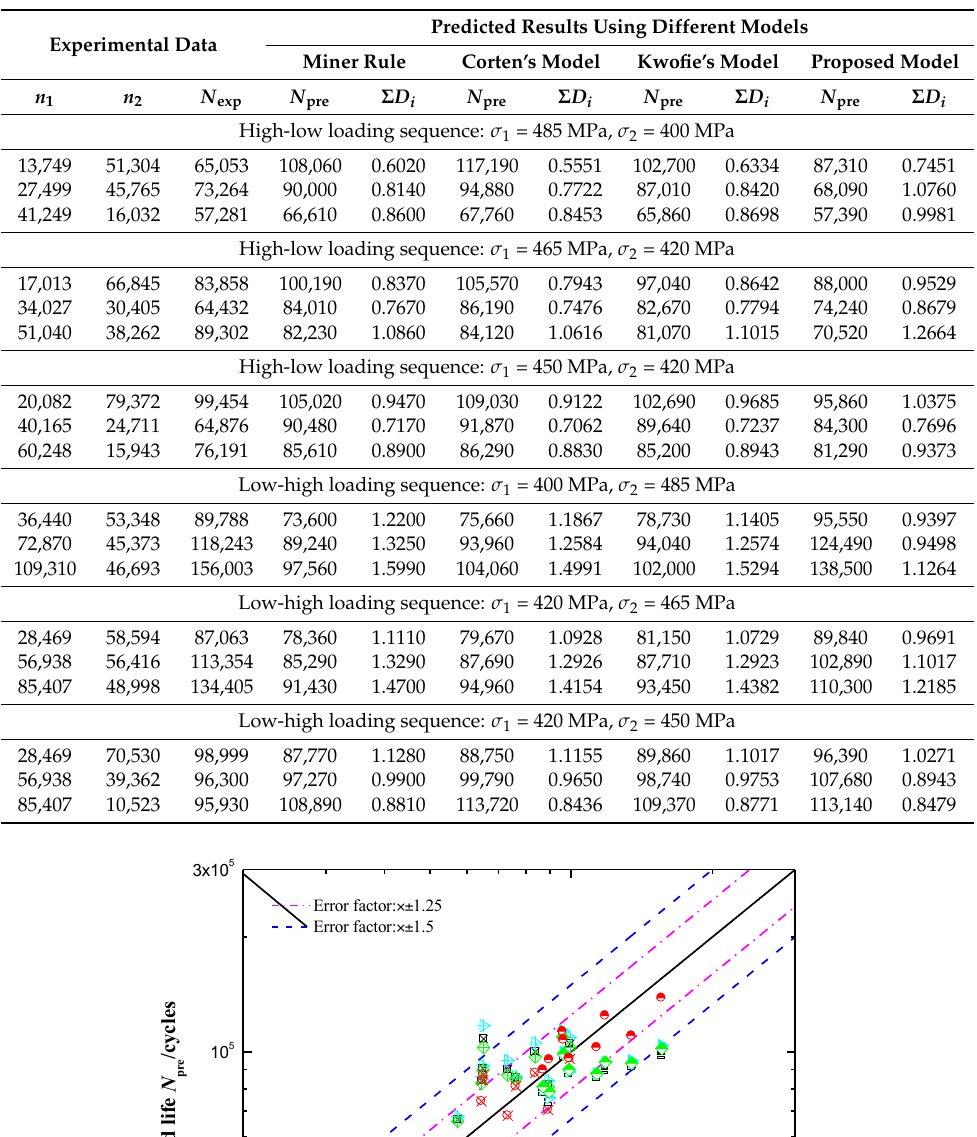
Table 4. Experimental data and models predictions for 30NiCrMoV12 steel.